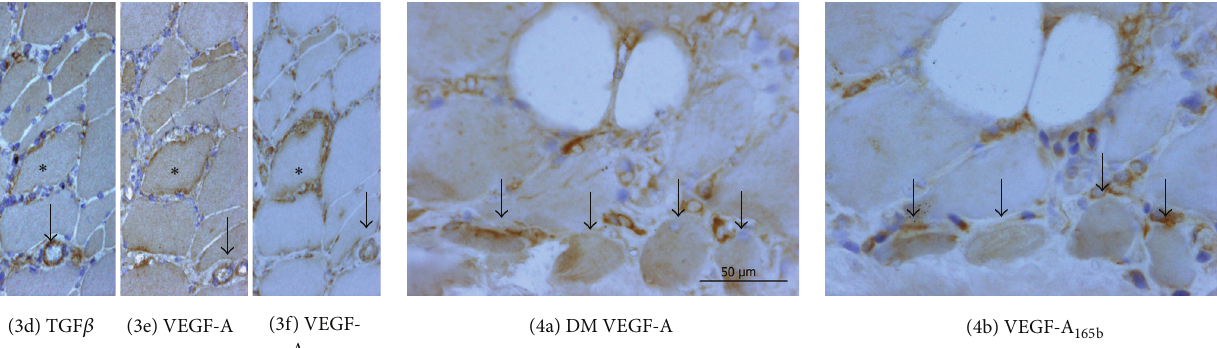
Figure 4: Representative images of immunohistological distribution of VEGF-A, VEGF-A 165 , and TGF- 𝛽 in inflammatory myopathies. b (1 a ) – (1 f ) Consecutive sections, IBM. Regenerating fibres (asterisk), basophilic (1a) and reactive for foetal myosin heavy chain (1d), show reactive (1c), in contrast with VEGF-A (1b) upregulation, against basal expression of adjacent fibres. These fibres are strongly VEGF-A 165 b low or null reactivity of adjacent fibres, and show highly reactive foci. Small endomysial vessels are diffusely VEGF-A and VEGF-A 165 b reactive. A mild VEGF-A 165 upregulation (1c: arrow) is observed in nonregenerating fibres displaying sarcolemmal and cytoplasmic HLA- b ABC neoexpression (1e: arrow). (1 f ) Negative control slide. (2 a ) – (2 c ) Consecutive sections, PM. Necrotic fibres, identified by deposits of the terminal complex of complement, or membranolytic attack complex (MAC) (2a: arrow), do not express neither VEGF-A (2b: arrow) nor (2c: arrow), appearing as unreactive pale elements. Mononuclear cells surrounding and partially invading the necrotic fibre (2c: VEGF-A 165 b . (3 a ) – (3 c ) Consecutive sections, IBM. Fibres with rimmed vacuoles (3a, arrows) show VEGF- asterisk) are strongly reactive for VEGF-A 165 b upregulation with multiple spots of intense reactivity (3c, A upregulation (3b, arrows), with occasional highly reactive foci, and VEGF-A 165 b . (3 d ) – (3 f ) IBM. TGF- 𝛽 arrows). Mononuclear infiltrates show a scarce reactivity for VEGF-A (3b), whereas they strongly express VEGF-A 165 b (3d) is expressed on a large endomysial vessel (arrow) and inflammatory cells. Muscle fibres of smaller diameter show higher reactivity. On nonadjacent serial sections, localization of both VEGF isoforms is observed ((3e)-(3f)) in the vessel. The asterisk identifies a fibre surrounded by inflammatory cells. (4 a ) - (4 b ) Consecutive sections, DM. Perifascicular atrophic fibres (arrows) show increased reactivity for angiogenic (3a) and antiangiogenic (3b) VEGF isoforms. Mononuclear cells also react for both